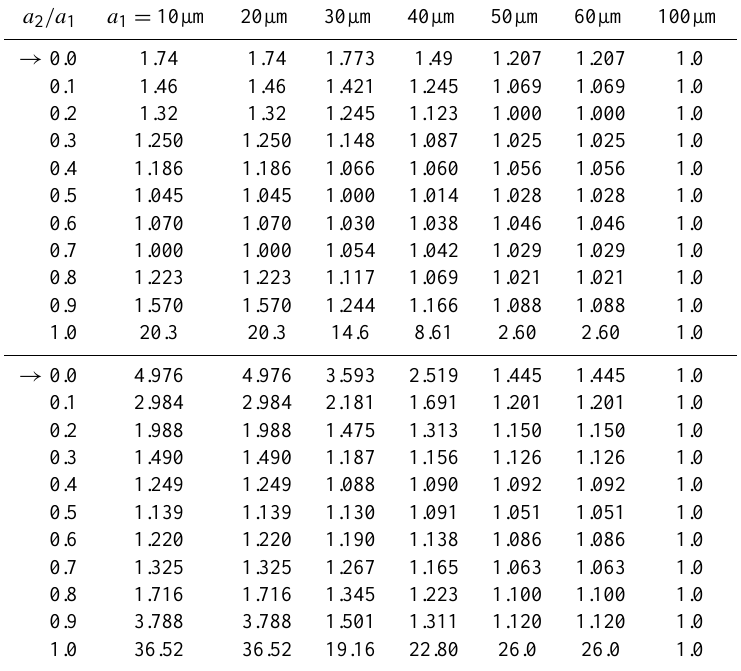
Table 1. The enhancement factor η E of the collision efficiency. The upper/lower part of the table is for (cid:15) = 100 / 400cm 2 s − 3